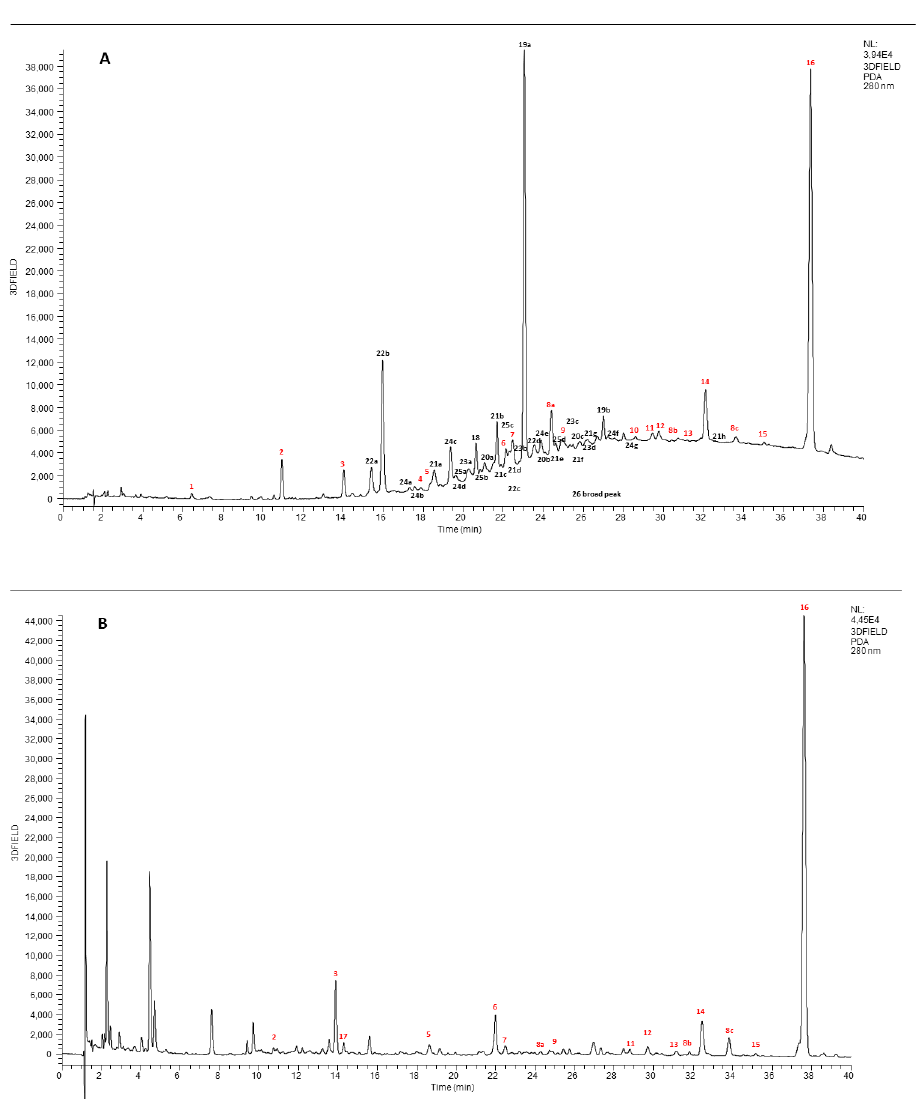
Figure 1. UHPLC ‐ DAD chromatographic separation (280 nm) of cinnamon extract before ( A ) and Figure 1. UHPLC-DAD chromatographic separation (280 nm) of cinnamon extract before ( A ) and after ( B ) digestion. after ( B )